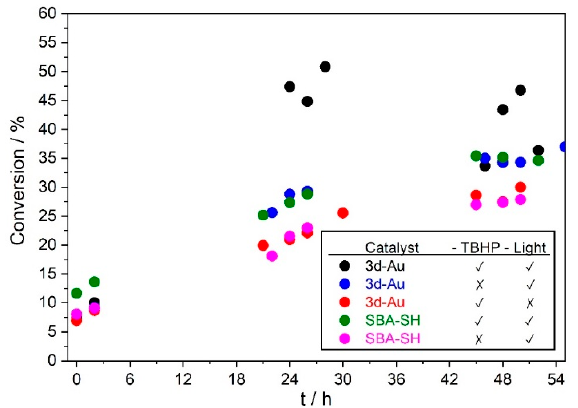
Figure 9. Comparison of the conversion of cyclohexene as a function of time of the catalyst 3d-Au carried out under different reaction conditions.